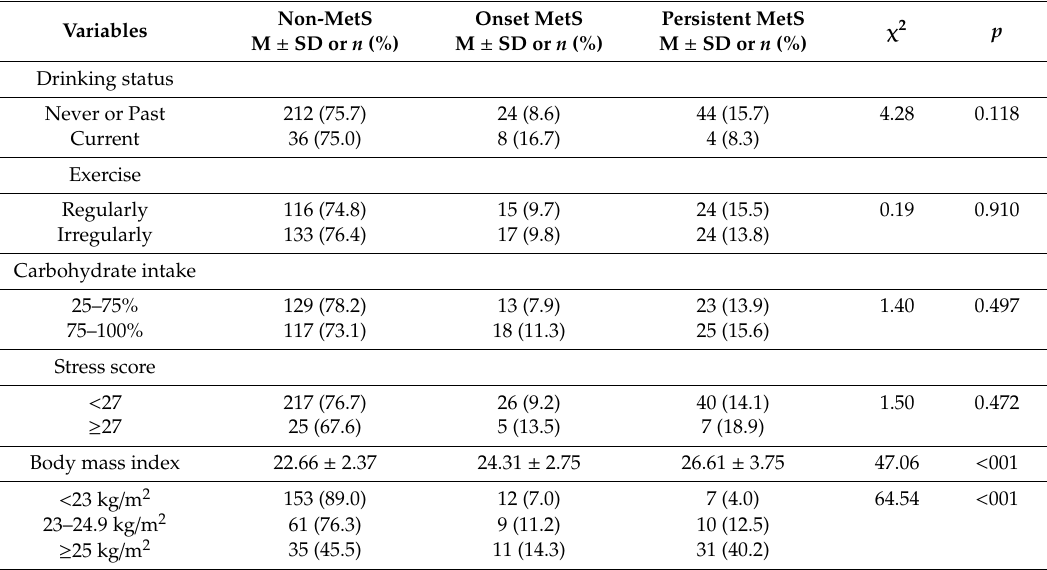
Table 2. Health behavior characteristics among breast cancer